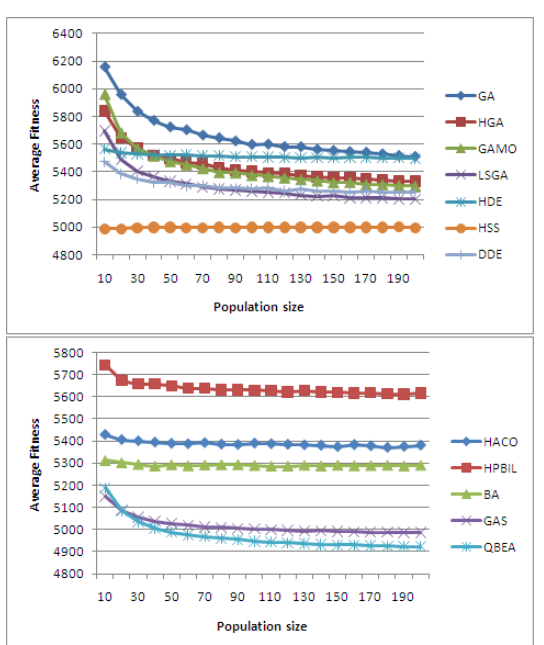
Fig. 4. Results – average fitness – instance 10. The values have been computed based on 30 different executions for each population size { 10 , 20 , ..., 200 }. For stop criterion we use 1000